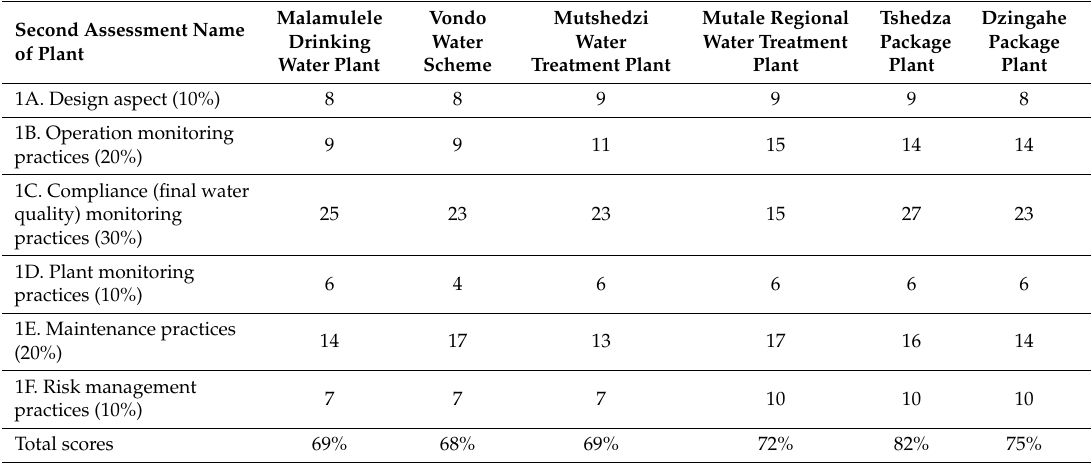
Table 10. Technical assessment: second assessment: period between November and December